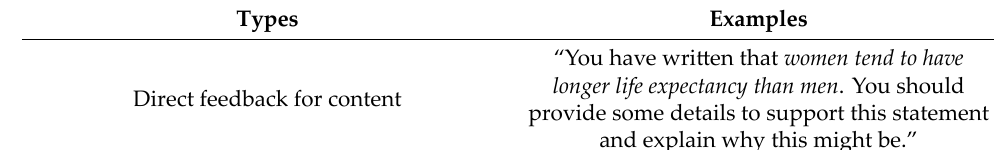
Table 1. Examples of the Teacher’s Written Corrective